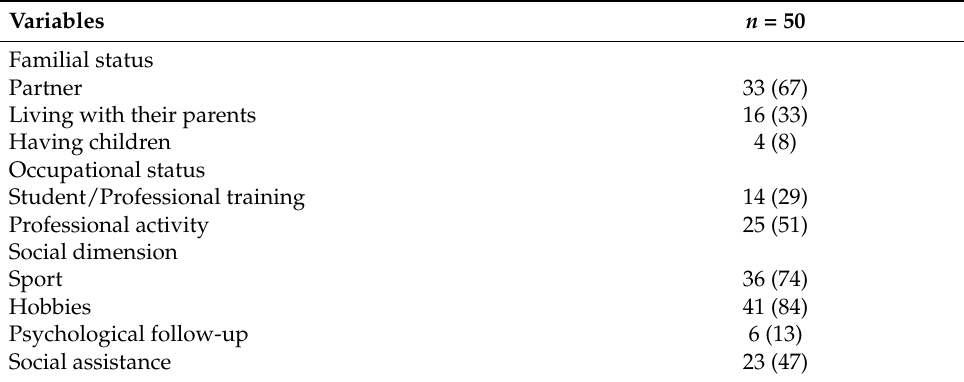
Table 2. Familial, occupational, and personal characteristics.